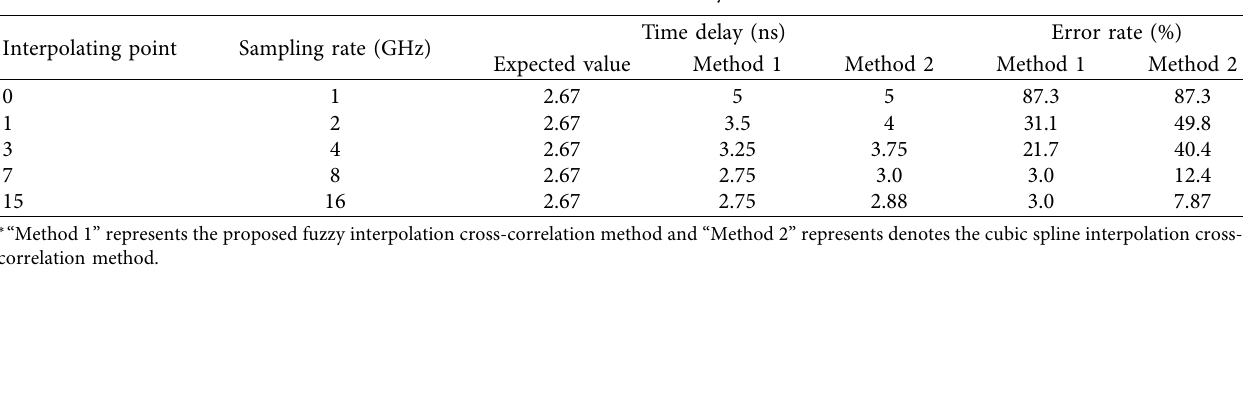
Table 3: The calculated time delay and errors.